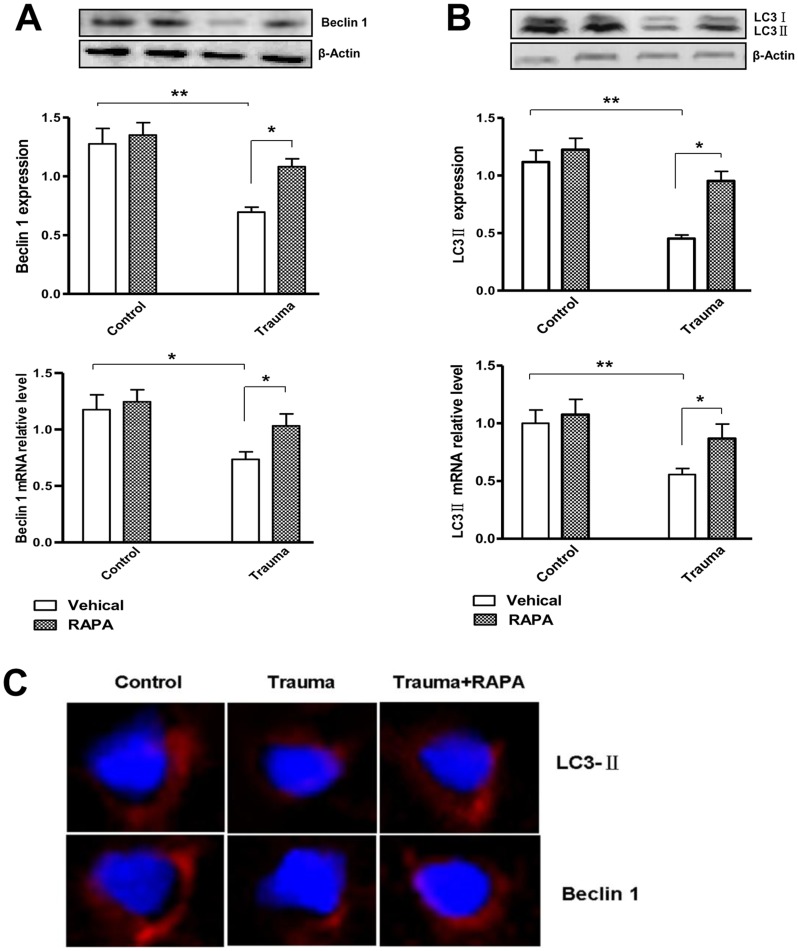
Rapamycin (RAPA) can induce autophagy.After the injection of rapamycin and vecicle 30 min before trauma, the rats were sacrificed at 6 h after trauma. (A and B) The protein and mRNA levels of Beclin 1 and LC3 were detected. Data are expressed as Mean±SD (n = 6). * p<0.05; ** p<0.01. (C) Confocal images of Beclin 1 and LC3. Beclin 1 and LC3 immunoreactivity were present as punctate pot (red) and the nucleus were stained with DAPI (blue). Compared with control-operated animals, trauma group showed decreased staining of Beclin 1 and LC3 6 h after injury. Treatment with rapamycin (RAPA) partially reversed nonlethal trauma-induced down-regulation of staining.